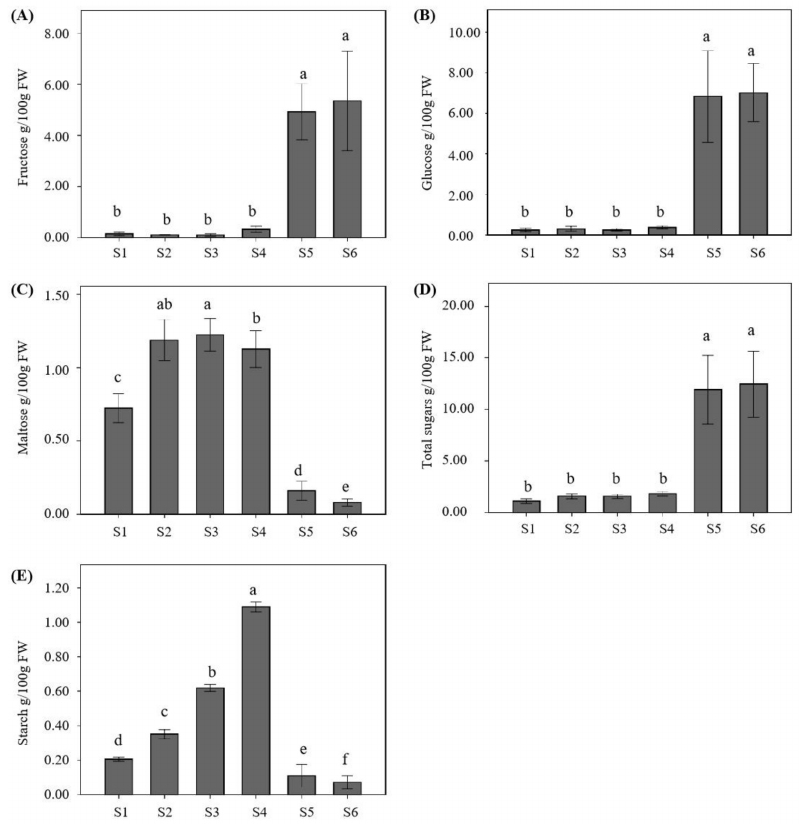
Figure 4. Dynamic changes of concentrations of fructose ( A ), glucose ( B ), maltose ( C ), total sugars (the sum of glucose, fructose, and maltose) ( D ), and starch ( E ) during the fruit development of S. obovatifoliola subsp. urophylla . The different letters in each figure indicate significant differences at the p < 0.05 level using the LSD test. S1: 60 DAFB (days after full bloom), S2: 90 DAFB, S3: 130 DAFB, S4: 160 DAFB, S5: 190 DAFB, S6: 205